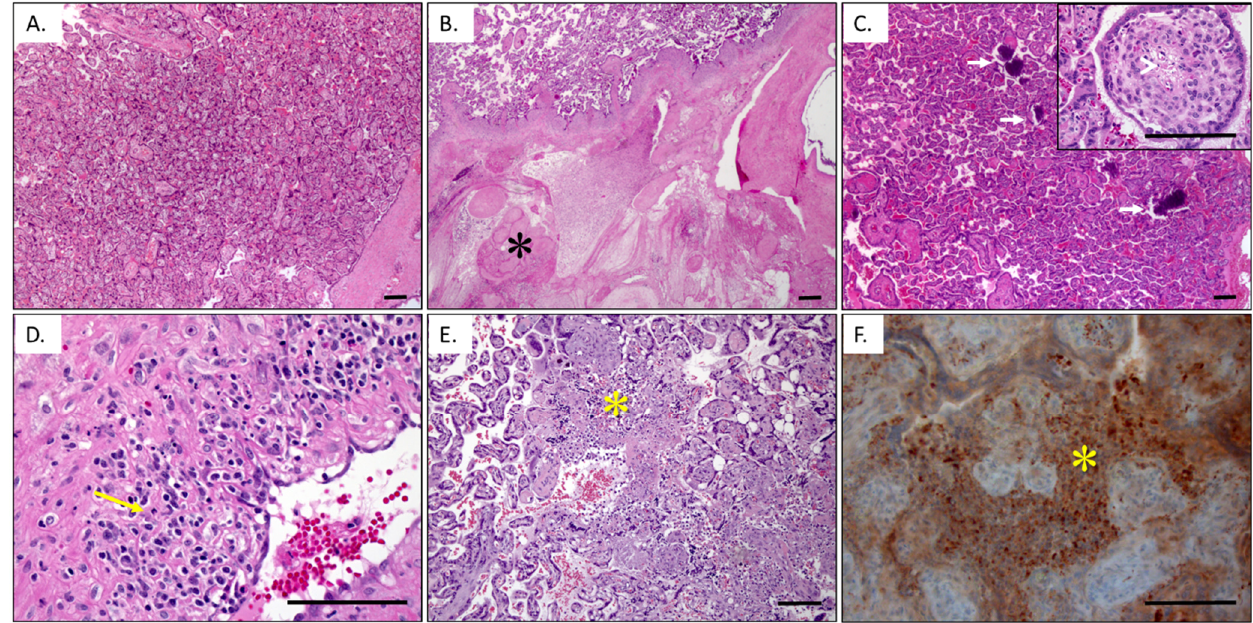
Figure 1. Zika related uteroplacental pathology. ( A ) Gestational age-matched negative control placental histology. In contrast, Zika infected placentas ( B , C ) are more likely to have lobular infarctions (*) and villous stromal microcalcifications (arrows). Early stages of villous stromal cell death are also seen (inset arrowhead). ( D ) Some cases have maternal decidual leukocytoclastic vasculitis composed of lymphocytes, plasma cells, and eosinophils (arrow). ( E ) Preliminary data in NHP models suggest a potential relationship with chronic histiocytic intervillositis (*), which is supported by CD68-positive macrophages (*) in the intervillous space around viable villi ( F ). Photomicrographs of hemotoxylin- and eosin-stained sections ( A – E ), as well as immunohistochemical stained section with hematoxylin counterstain. Bar is 100 µm.